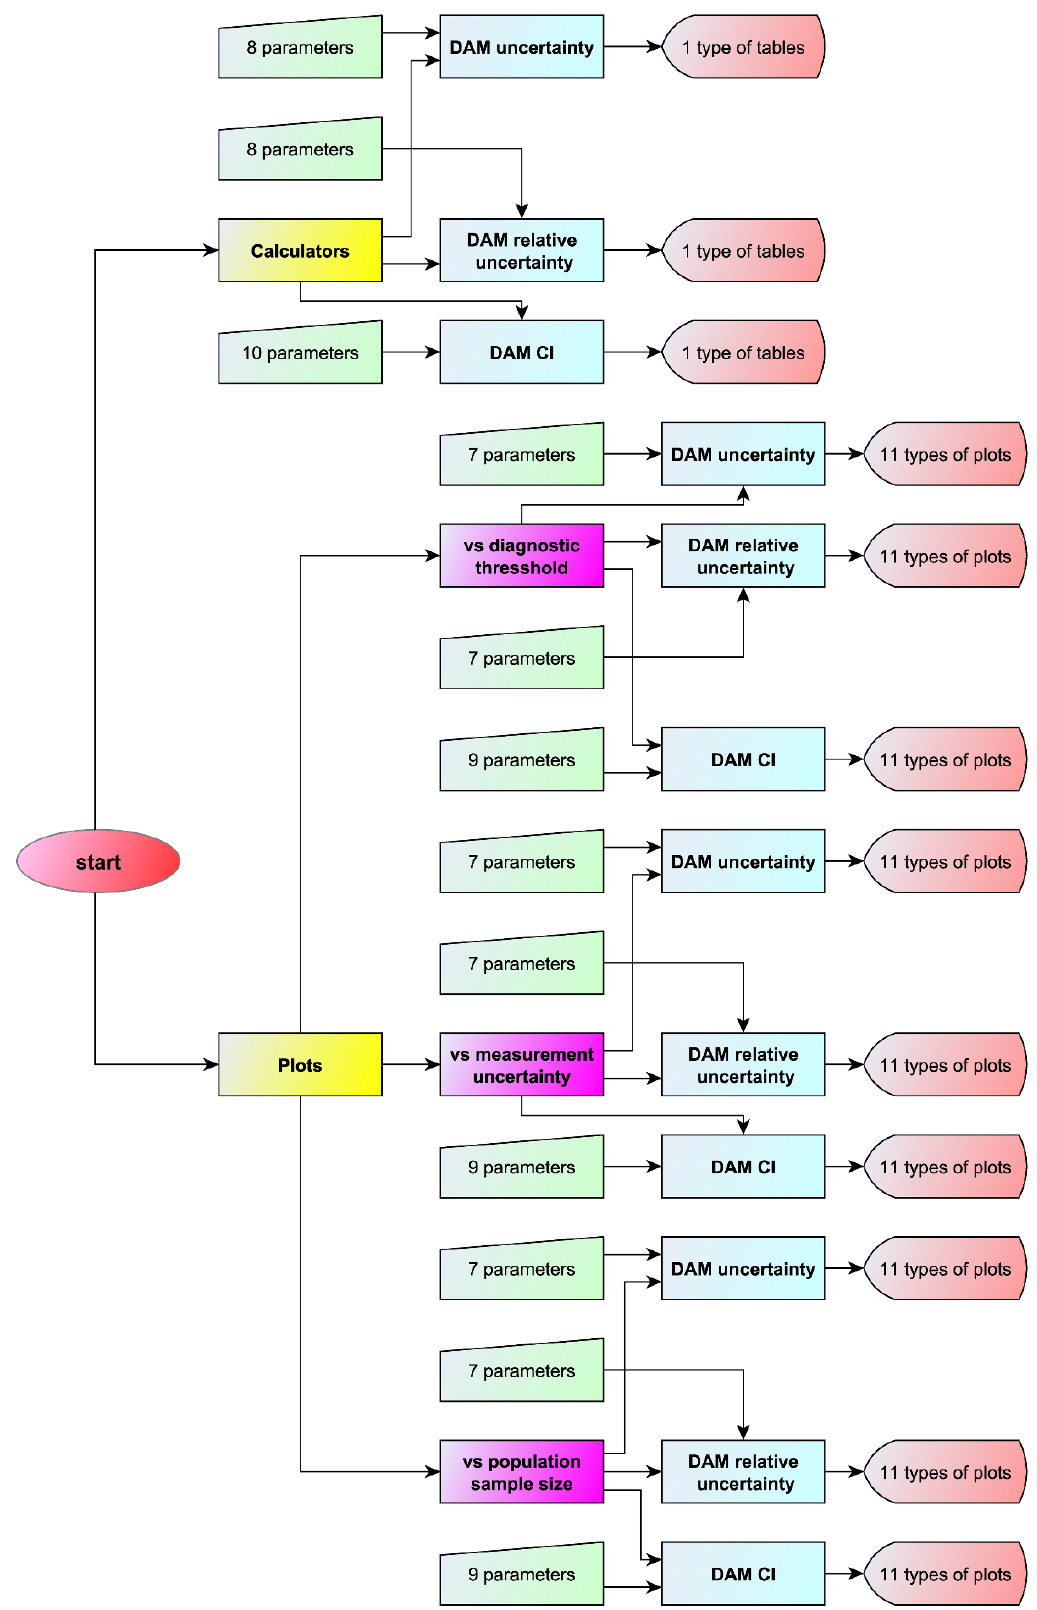
Figure 2. Program flowchart. The flowchart of the program with the number of the input parameters and of the output types for each module or submodule.